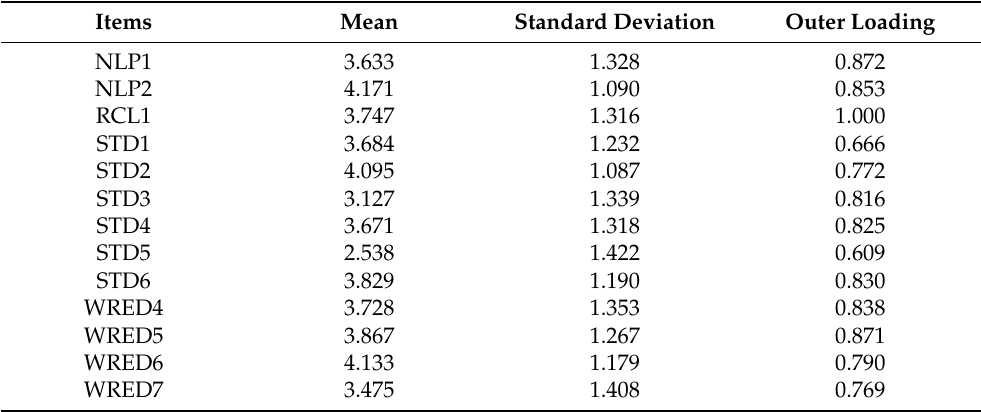
Table 8. Descriptive statistics for the remaining